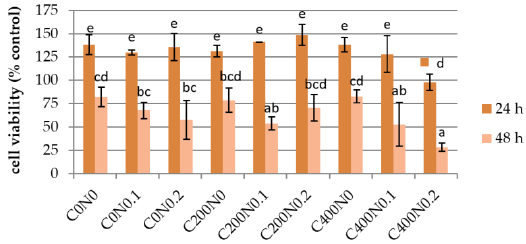
Figure 3. Growth curves showing proliferation rate of RAW 264.7 cells cultured on hydrogel. Vertical bars represent standard deviation. Values followed by different superscript letters (a–e) are significantly different ( p < 0.05).